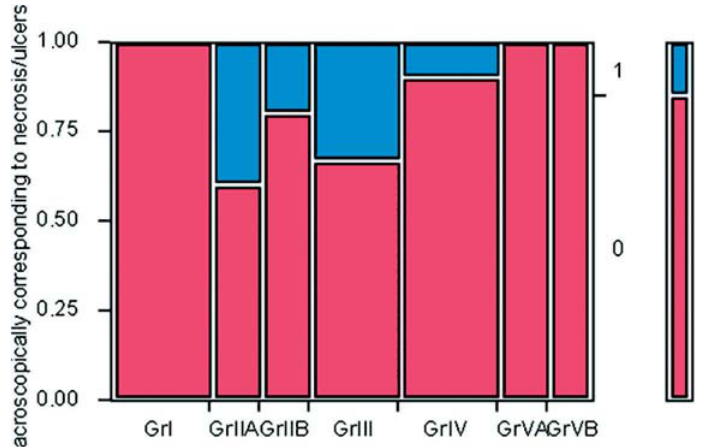
Figure 10- Macroscopic observation of the gastric mucosa in relation to parameter – Macroscopically corresponding to